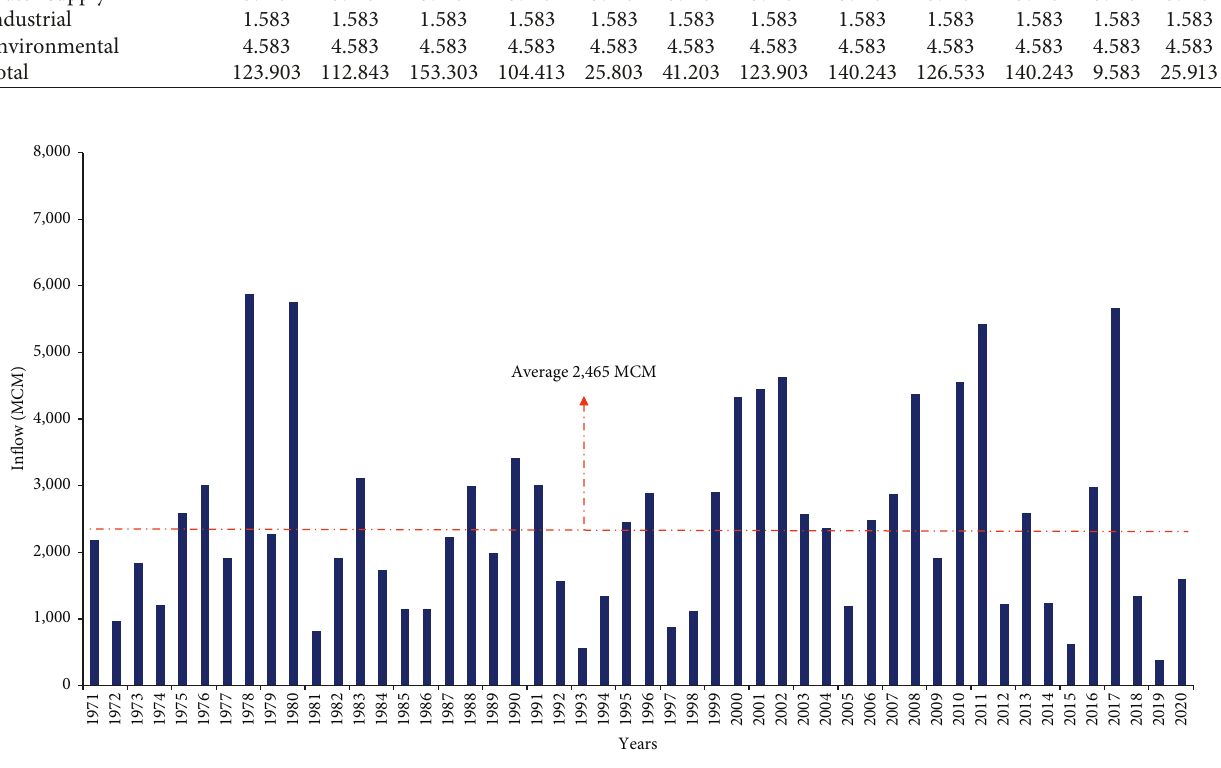
Figure 3: The yearly historic inflow into the Ubolratana reservoir.